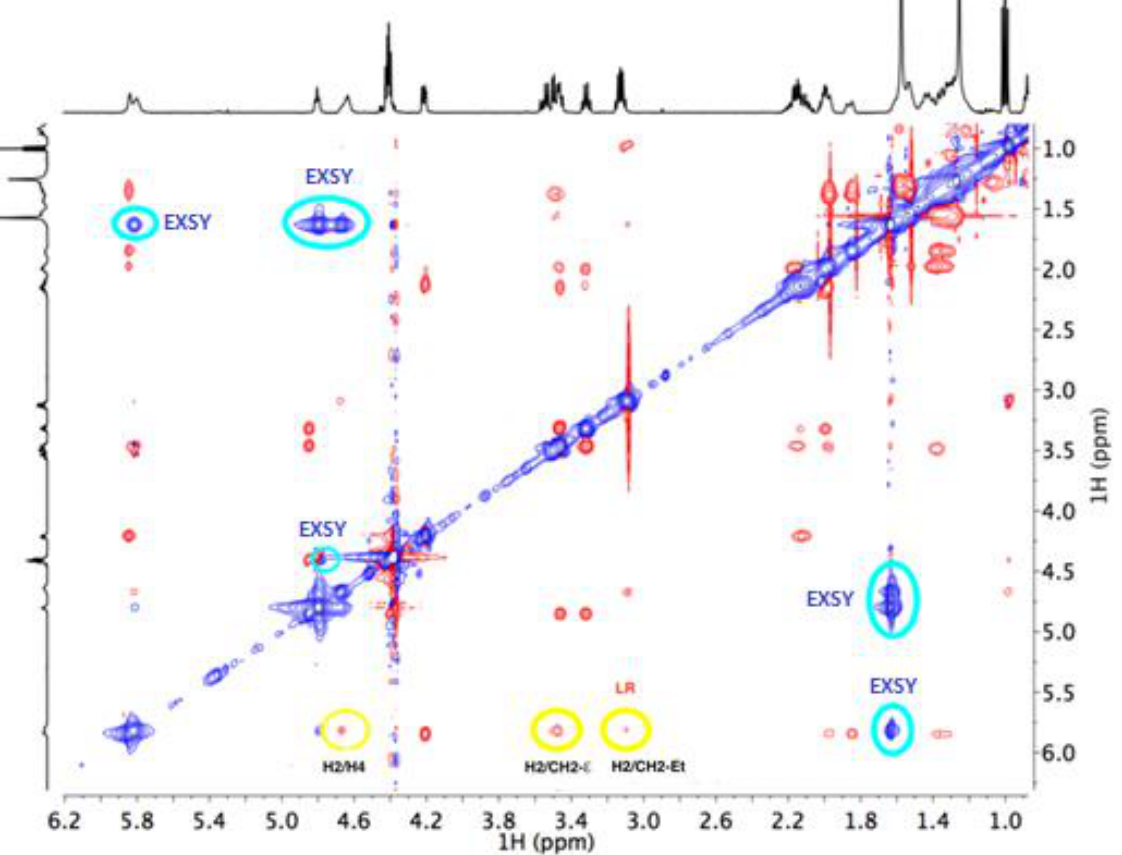
Figure 10. 2D NOESY spectrum of compound 3 at +25 ◦ C, t-mix = 600 ms (CDCl 3 , 500 MHz). Sign of NOE peaks; red negative, blue positive.